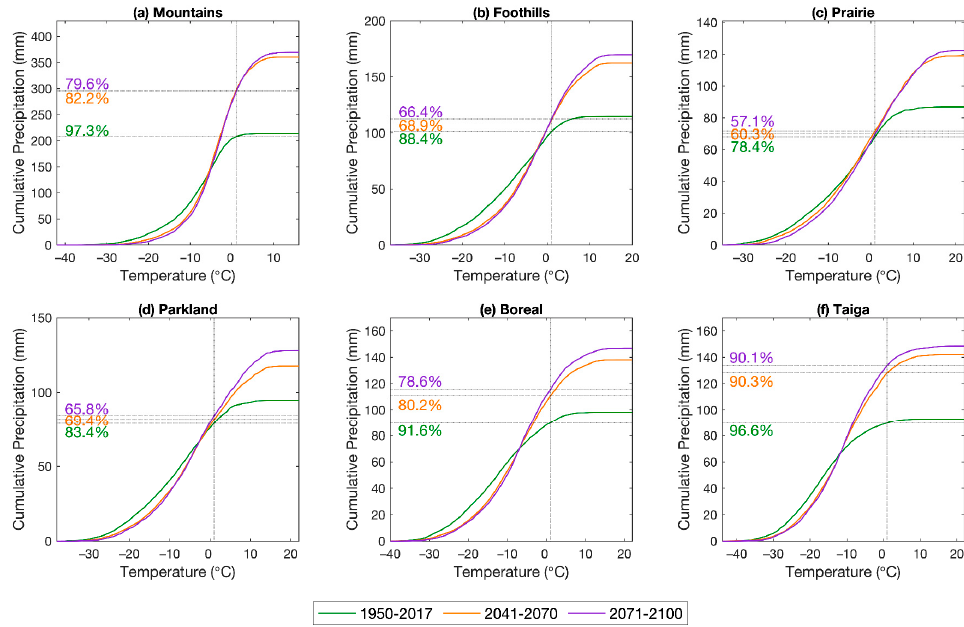
Figure 9. Cumulative precipitation by temperature distribution for RCP 4.5. Snowfall fraction is shown as a percentage of total precipitation along the left side of each ecozone graph.